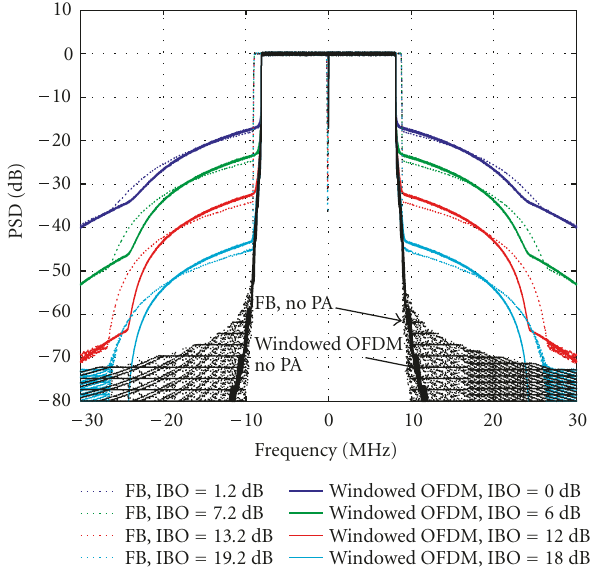
Figure 12: Spectral regrowth due to PA nonlinearity.